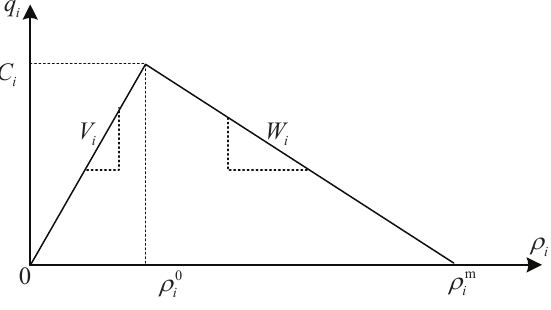
Figure 1. The triangular fundamental